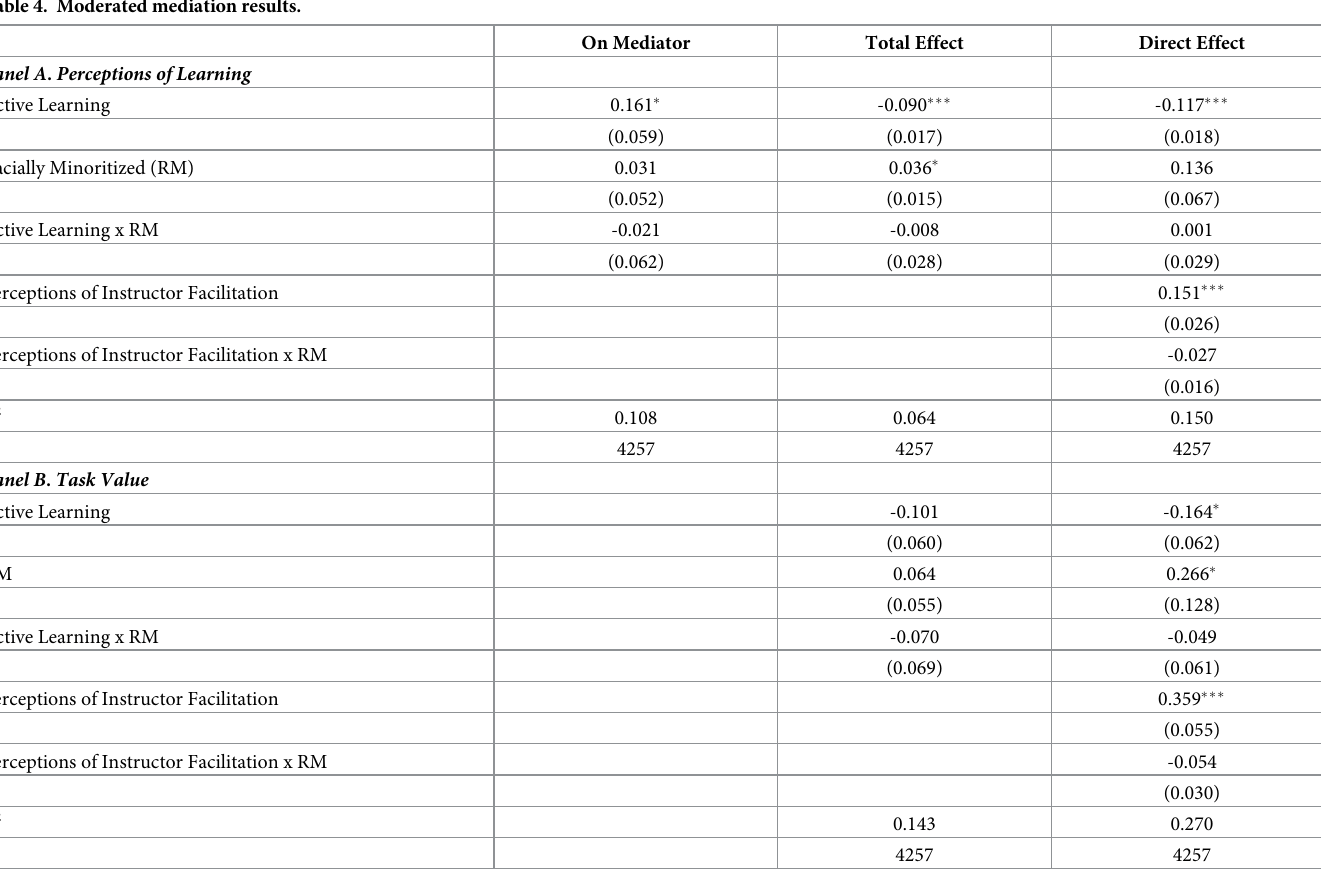
Table 4. Moderated mediation